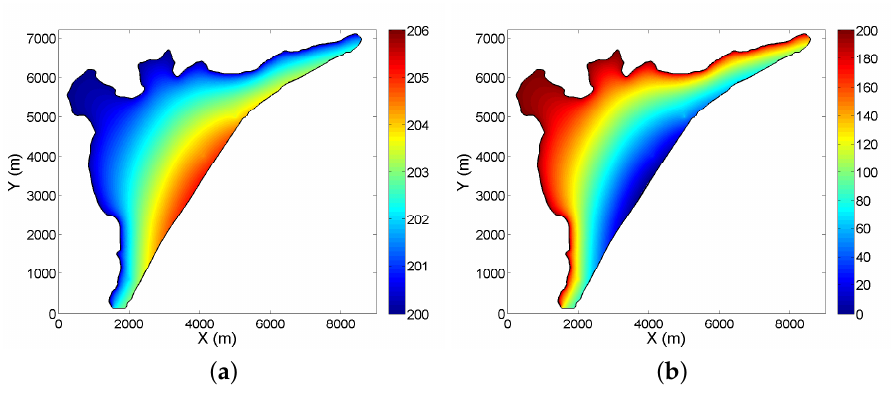
Figure 8. Interfaces in current situation; ( a ) Piezometric head h ; ( b ) Interface g .